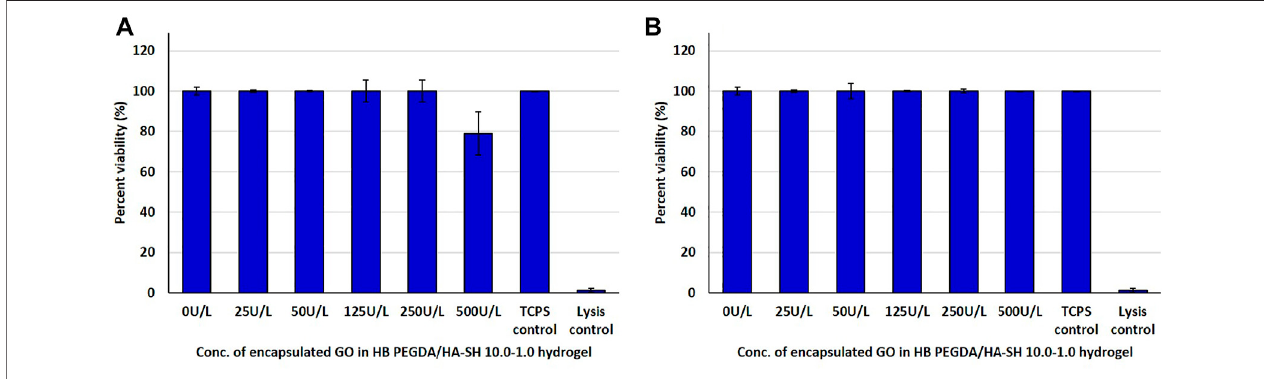
FIGURE 6 | Post 24 h cell viability data of HaCaT cells interacting with H 2 O 2 -releasing HB PEGDA/HA-SH 10.0 – 1.0 hydrogels containing different amounts of GO (25 – 500 U/L) and constant G amount (2.5% w/w) using the quantitative CTB assay: (A) direct contact and (B) indirect contact